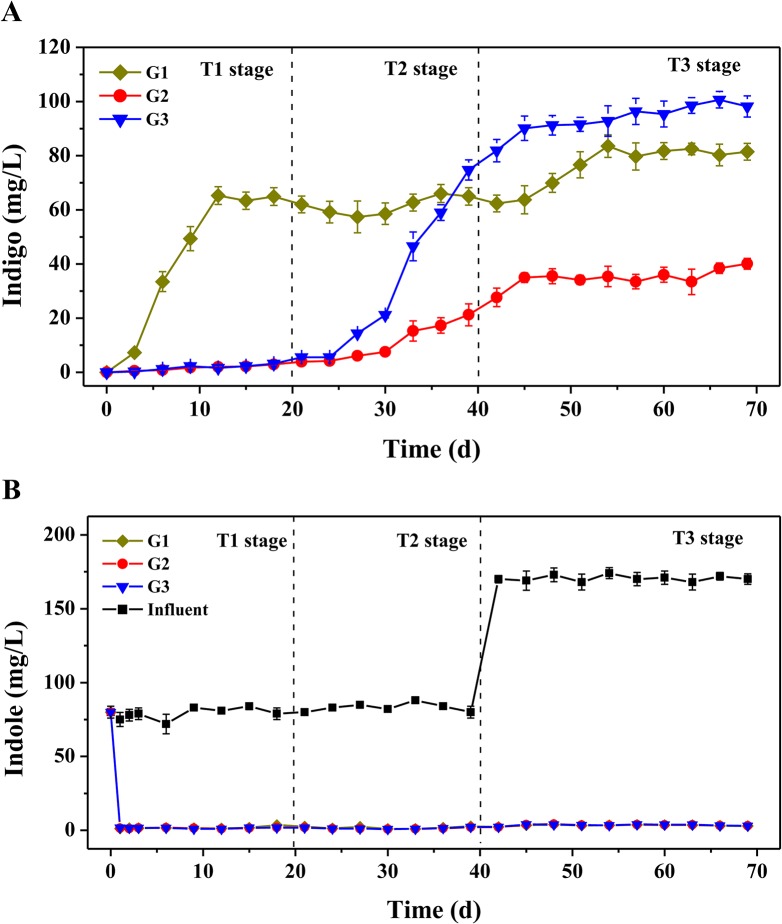
Biosynthesis of indigo from indole by three activated sludge systems stimulated by different aromatics.
A. Indigo production by three activated sludge systems. B. Indole consumption by three activated sludge systems. G1, naphthalene plus indole; G2, phenol plus indole; G3, indole only. The concentrations of indigo and residual indole were measured by HPLC at the end of each SBR operation cycle. Detailed group setup were presented in Table A in S1 File.